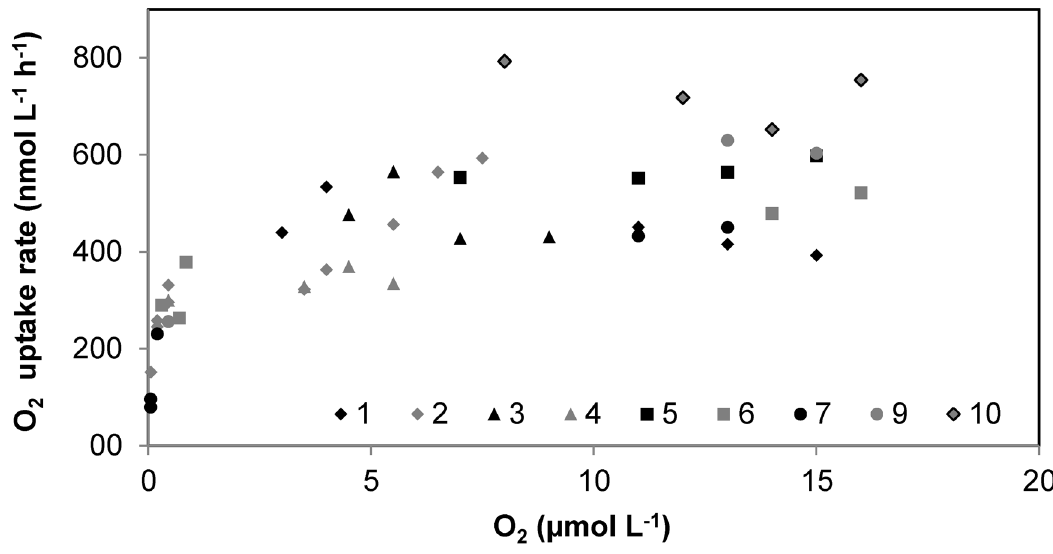
Figure 4. O 2 consumption rate versus O 2 concentration from Station 1 (Randers Fjord, September 2011). Each type of symbol corresponds to a specific bottle. Replicate bottles were incubated over range of initial O 2 concentrations varying from 0 to 20 m mol L 2 1 . Rates were calculated as slopes over different O 2 concentration change intervals: from 17 - 6 m mol O 2 for every 2 m mol L 2 1 intervals, from 6 - 1 m mol L 2 1 O 2 for every 1 m mol L 2 1 intervals. Afterwards over the following intervals: 500 - 300, 300 - 100, and 100 - 5 nmol L 2 1 .